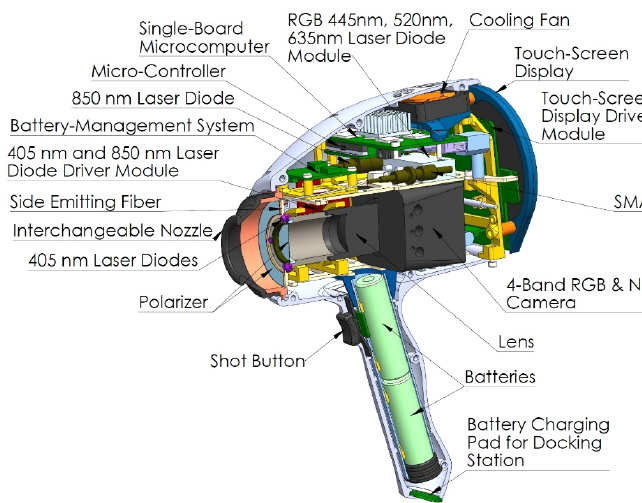
Figure 3. Design scheme of the prototype device.